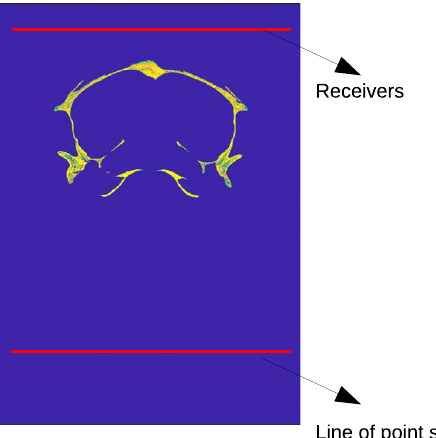
Figure A.1. Con fi guration of 2D tests for investigating the effect of downsampling.